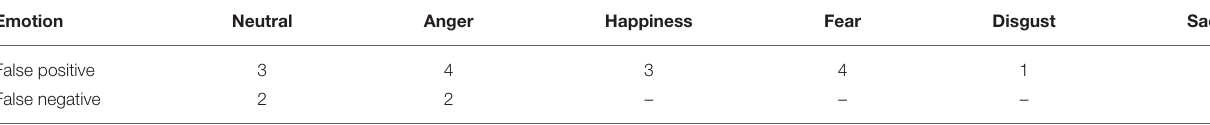
TABLE 2 | Results from the emotion recognition task. Emotion Neutral Happiness